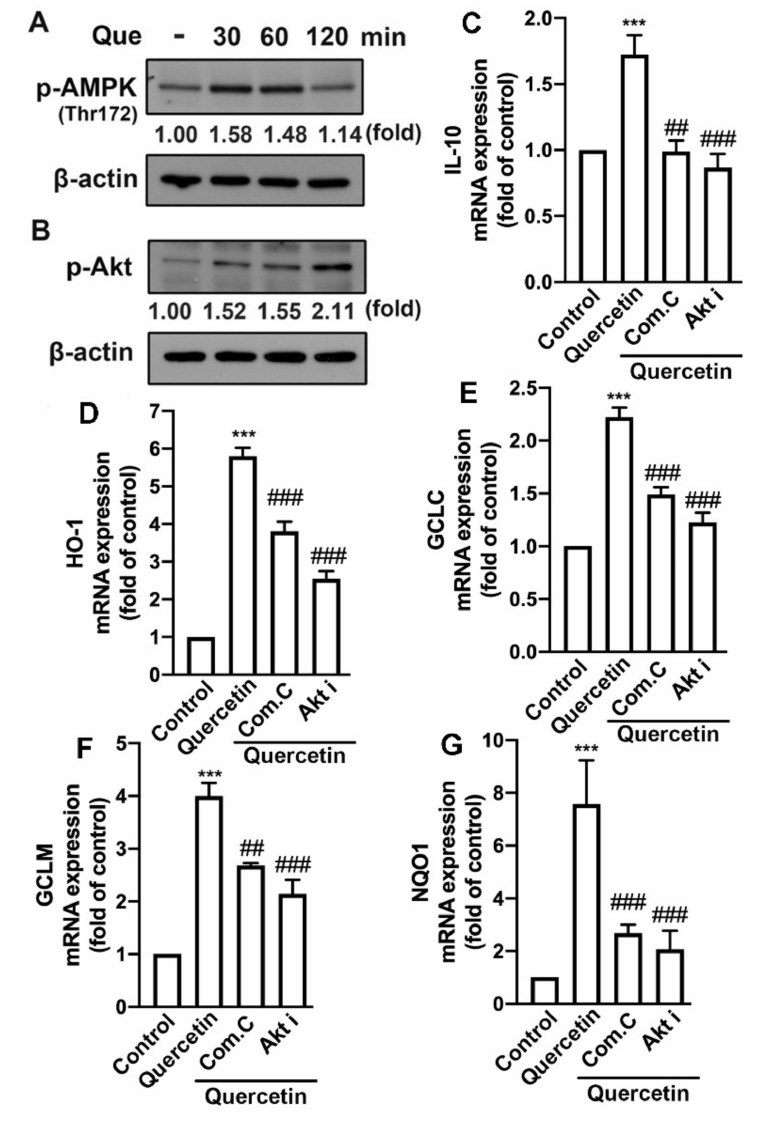
Figure 11. AMP-activated protein kinase (AMPK) and Akt signaling pathways are involved in the expression of quercetin-upregulated endogenous antioxidants. IMG cells were treated with quercetin (10 µ M) for the indicated time periods (30, 60, or 120 min). The phosphorylated levels of AMPK ( A ) and Akt ( B ) were determined by western blotting analysis. Cells were treated with the AMPK inhibitor compound C (15 µ M) or Akt inhibitor (10 µ M) for 30 min and then stimulated with quercetin (10 µ M) for 6 h. mRNA levels of IL-10 ( C ), HO-1 ( D ), GCLC ( E ), GCLM ( F ), and NQO1 ( G ) were analyzed by real-time PCR and normalized to β -actin. Each bar represents the mean ± SEM of n = 3–4. *** p < 0.005 compared with the control group. Note: ### p < 0.005, ## p < 0.01 compared with the quercetin alone